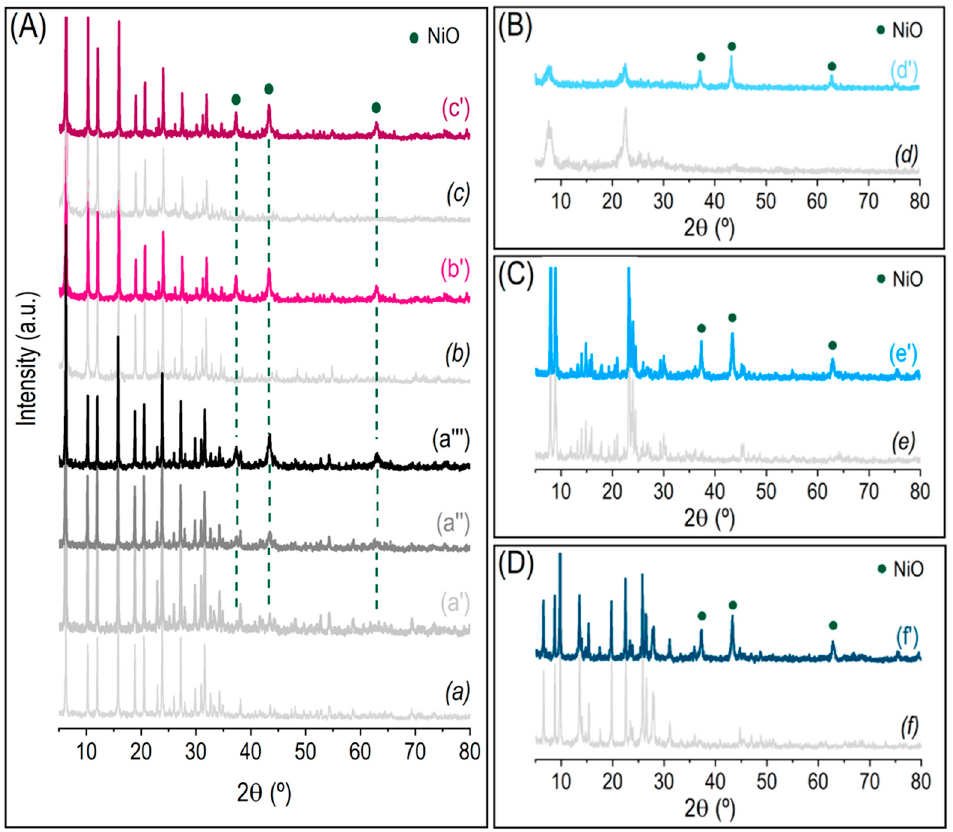
Figure 1. XRD patterns collected for: ( A ) USY-based samples: ( a ) USY(3), ( a ′ ) 5Ni/USY(3), ( a ″ ) 10Ni/USY(3), ( a ‴ ) 15Ni/USY(3), ( b ) USY(15), ( b ′ ) 15Ni/USY(15), ( c ) USY(38), and ( c ′ ) 5Ni/USY(38); ( B ) BEA-based samples: ( d ) BEA(38), ( d ′ ) 15Ni/BEA(38); ( C ) ZSM-5-based samples: ( e ) ZSM-5(40), ( e ′ ) 15Ni/ZSM-5(40); and ( D ) MOR-based samples: ( f ) MOR(47) and ( f ′ )15Ni/MOR(47). Table 2. Textural properties obtained using N 2 sorption for all the samples from the present work and the corresponding supports.